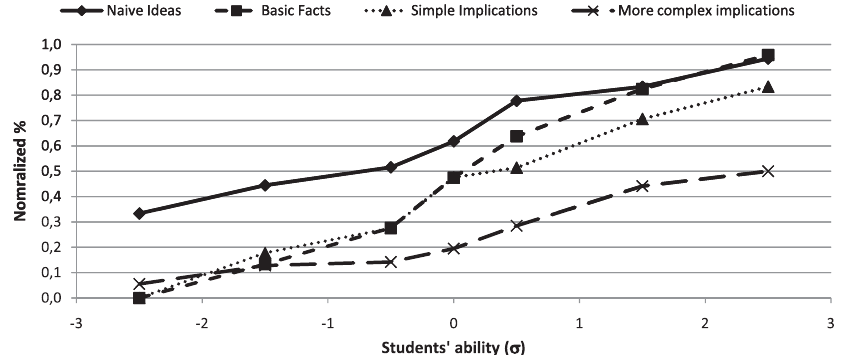
FIG. 7. IRC for cluster levels of the learning progression about change of seasons, Moon phases, and solar or lunar